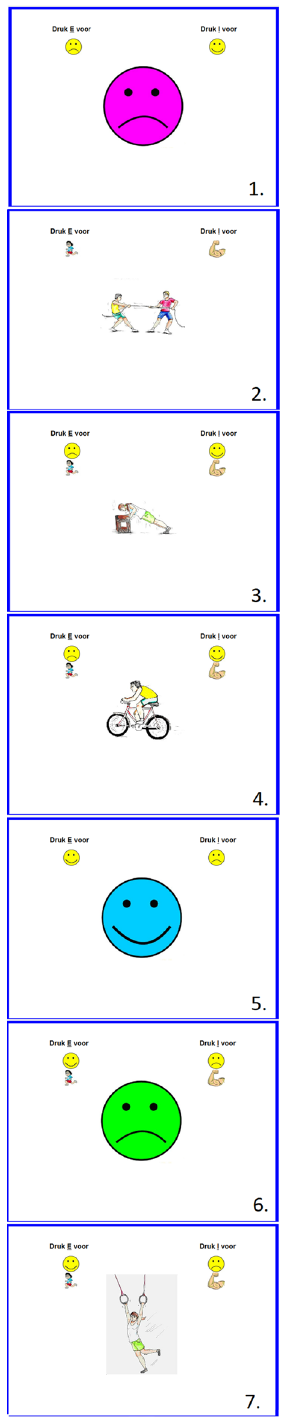
Figure 1: Phases in the Implicit Association